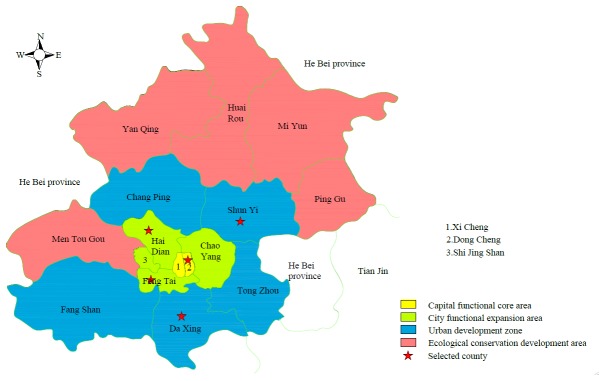
The map of Beijing.